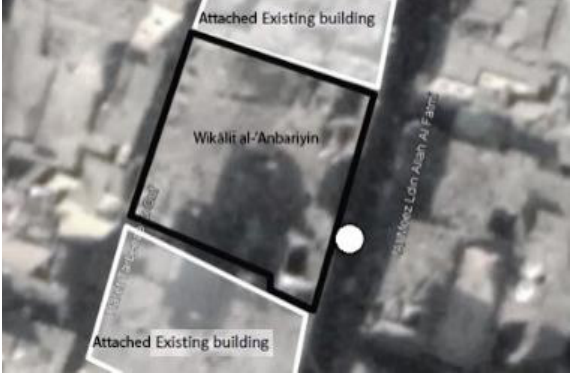
Figure 18. The white dashed rectangle indicates the same shop with the same sign, after Wikāliẗ ạl-’Anbariyin demolition.